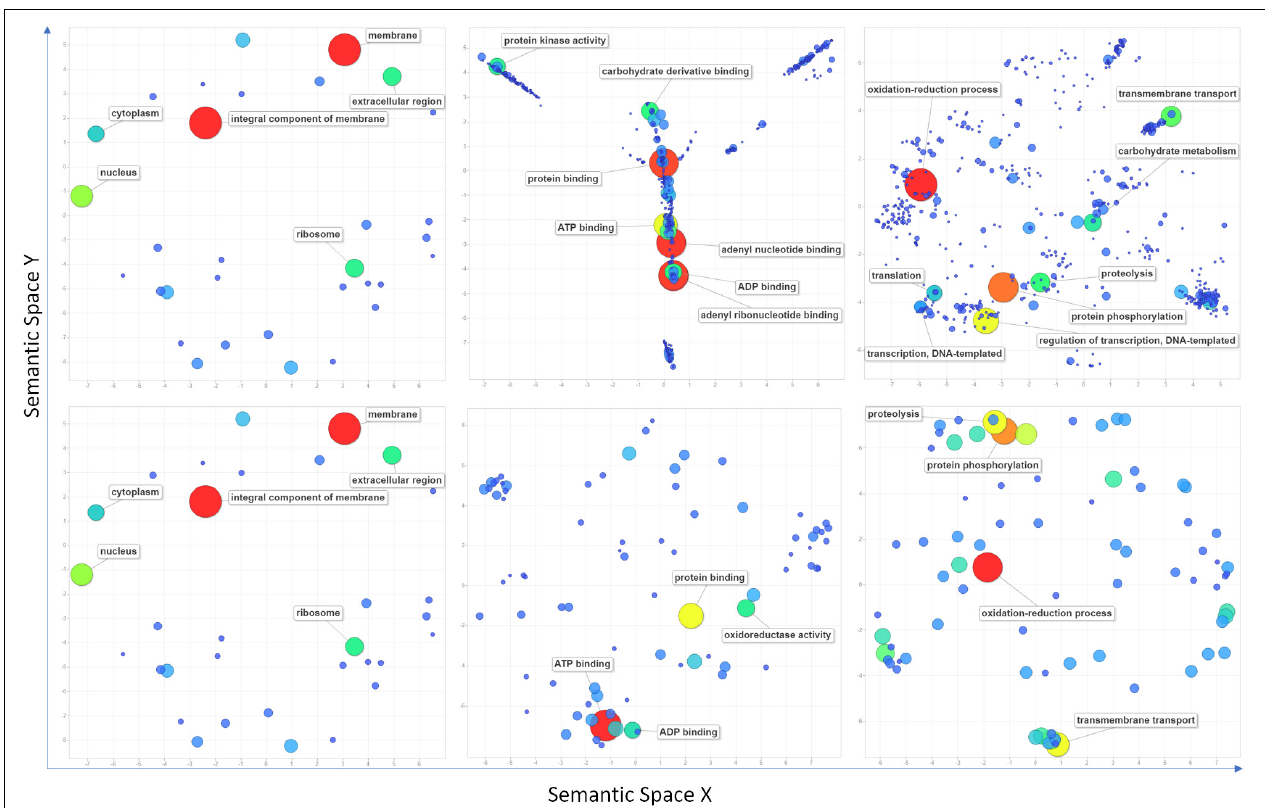
FIGURE 5 | Scatter plots show cluster representatives of GO terms for cellular components, molecular functions, and biological processes (left to right) in semantic spaces for all the retrieved genes (above) within a 1 Mbp window from localized significant SNPs and overlapping genes (below). The size and colors of dots indicate the number of genes. Coordinates of each dot in semantic space are detailed in Supplementary Table 8 . Terms with the highest values are mentioned in the